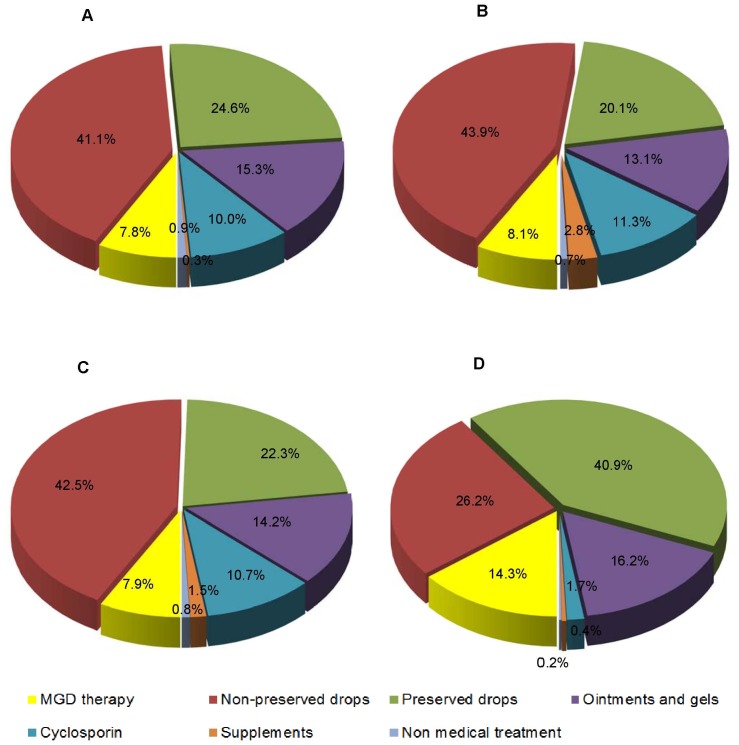
Relative expenditure & distribution of patient episodes of dry eye treatment categories in 2008 & 2009. 

Figure 3A
. Relative expenditure in 2008. 
Figure 3B

. Relative expenditure in 2009. 
Figure 3C

. Total expenditure in 2008 & 2009. 
Figure 3D:
 Distribution of patient episodes in 2008 & 2009